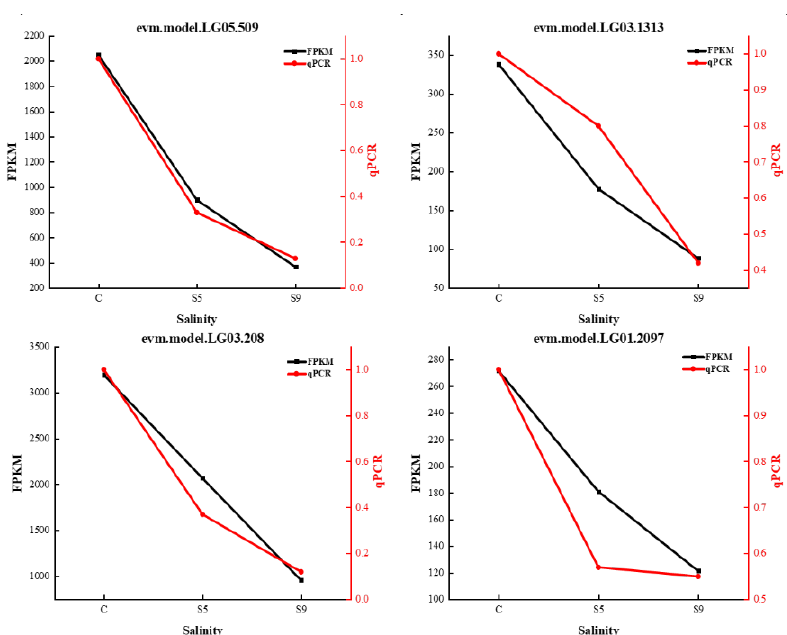
Figure 5. qRT-PCR results of ten unigenes for validation of RNA-seq data. (C: salinity 30 psu; S5: salinity 50 psu; S9: salinity 90 psu.)